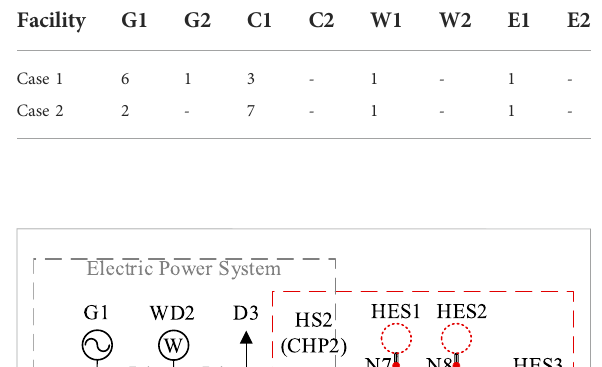
TABLE 2 Installation year of candidate facilities.